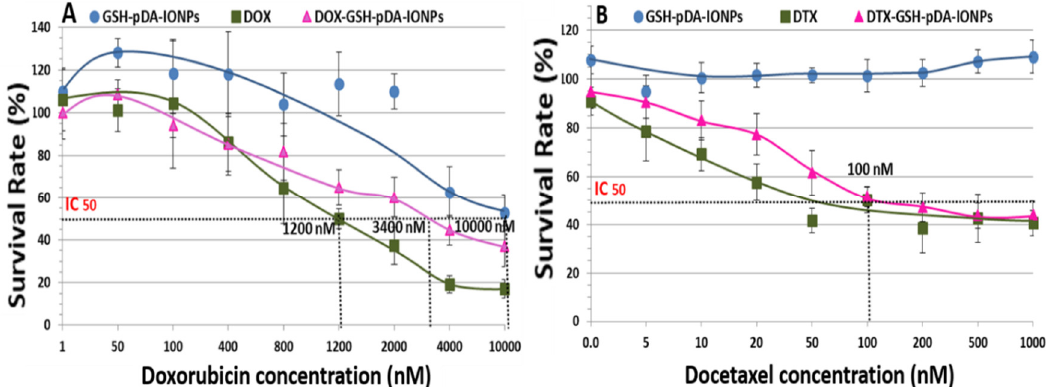
Figure 9. MTS ((3-(4,5-dimethylthiazol-2-yl)-5-(3-carboxymethoxyphenyl)-2-(4-sulfophenyl)-2H- tetrazolium)) assay showing the average percent of cell survival against various concentration of ( A ) DOX; and ( B ) DTX drug on PC3 cell lines when incubated for 48 h. (Standard deviations were calculated with six measurements).